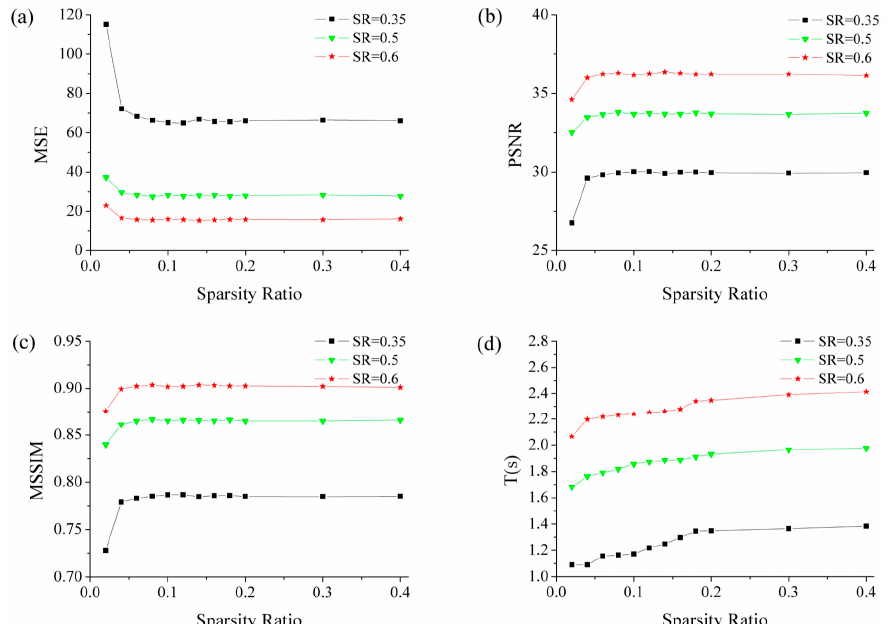
Figure 3. The effect of matrix sparsity ratio on its performance. With sampling ratio of 0.35, 0.5, and 0.6, the parameters MSE ( a ), PSNR ( b ), MSSIM ( c ) and reconstruction time T ( d ) change with sparsity ratio of measurement matrix. Each group of experiments is repeated 500 times.